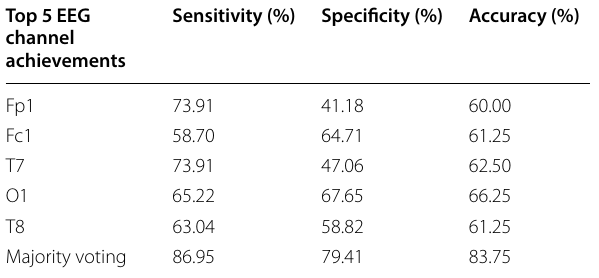
Table 2 Top 5 EEG channel achievements on alpha rhythm for HV vs LV classification